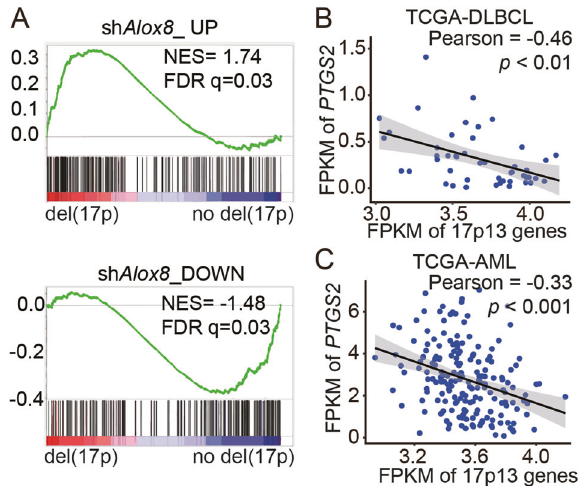
Fig. 4 Upregulation of cyclooxygenase pathway in lymphoma patients with del(17p) suggest new susceptibility. A GSEA plots showing that genes were chosen from top 200 upregulated (sh Alox8 _UP) or downregulated (sh Alox8 _DOWN) genes in sh Alox8 cells comparing to sh Ren cells signi fi cantly positively or negatively enriched in human chromosome 17p-deleted DLBCL cells. B , C Correlations between expression levels of PTGS2 and averages of chromosome 17p genes in TCGA-DLBCL or TCGA-AML. Data analyzed from TCGA-DLBCL ( n = 48) or TCGA-AML ( n =